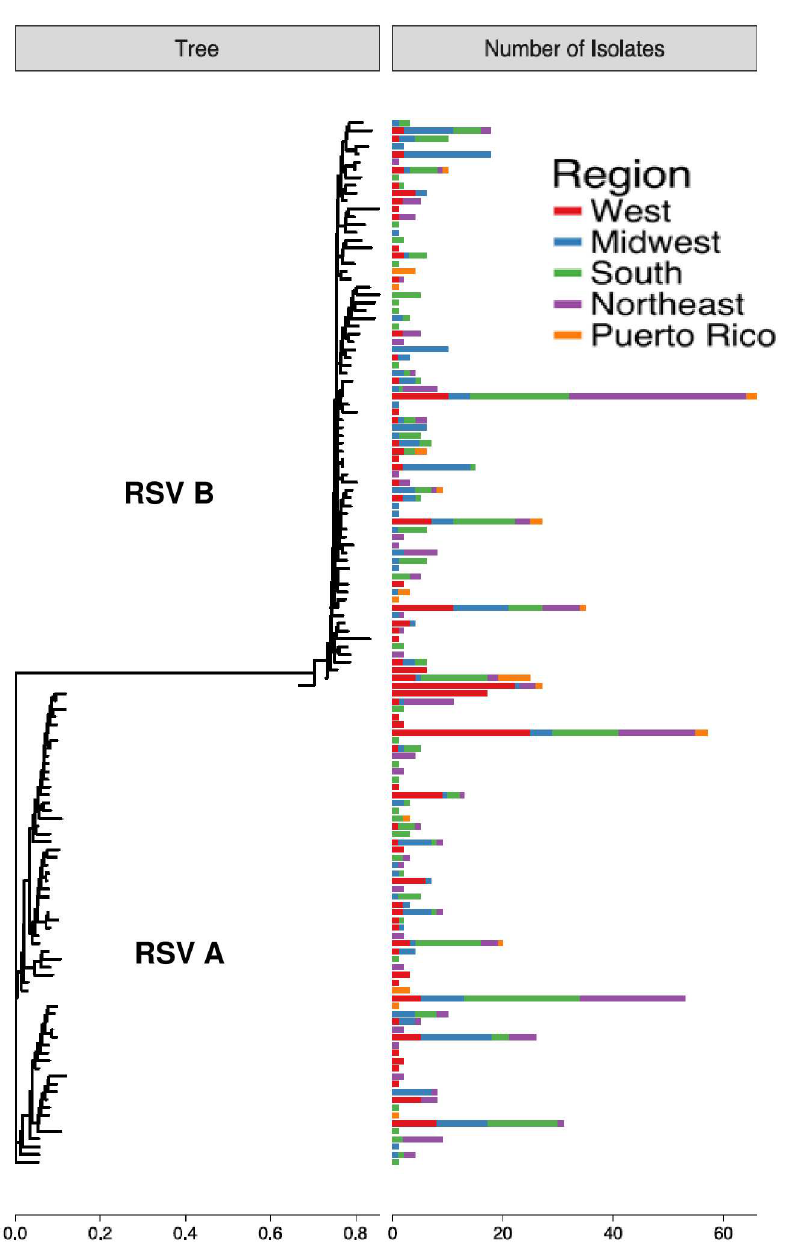
Fig 3. RSV A and B genotypes of 2016–17 OUTSMART samples by geographic region. The phylogenetic tree in the left panel was built using the representative G protein sequences from 97%-identity clusters, with the horizontal scale under the tree showing branch lengths derived from the dissimilarity metric. The corresponding bars in the right panel represent the number of samples in each cluster, with horizontal scale under the bar plot showing sample counts.